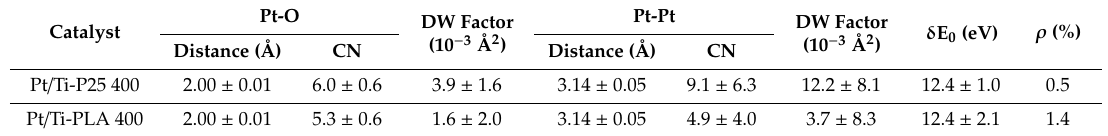
Table A2. Results of EXAFS fitting to a structural model containing O and Pt nearest neighbors.